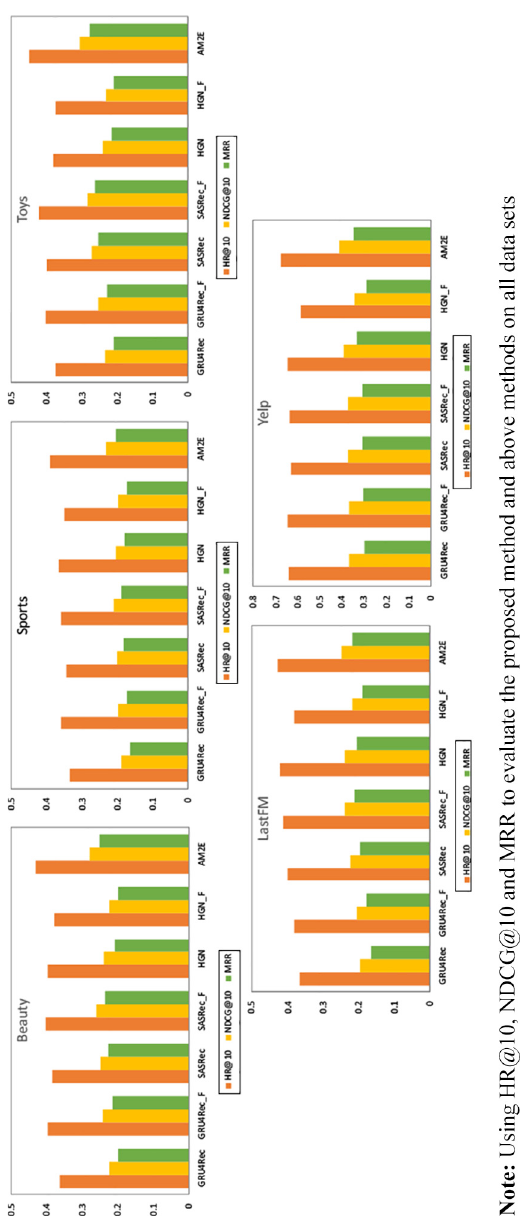
Figure 6. In fl uence of